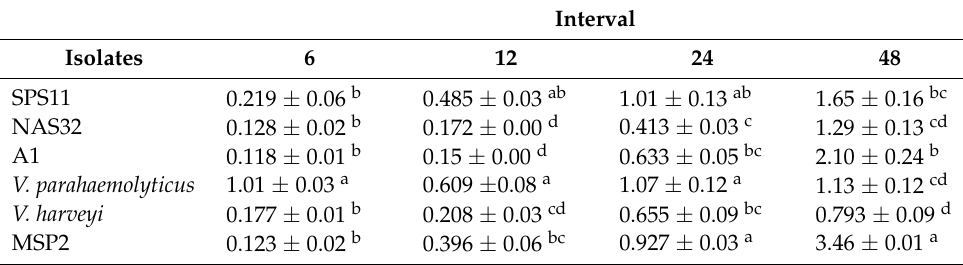
Table 4. Biofilm-forming ability of SSPs, pathogens and MSP2 at different time interval.